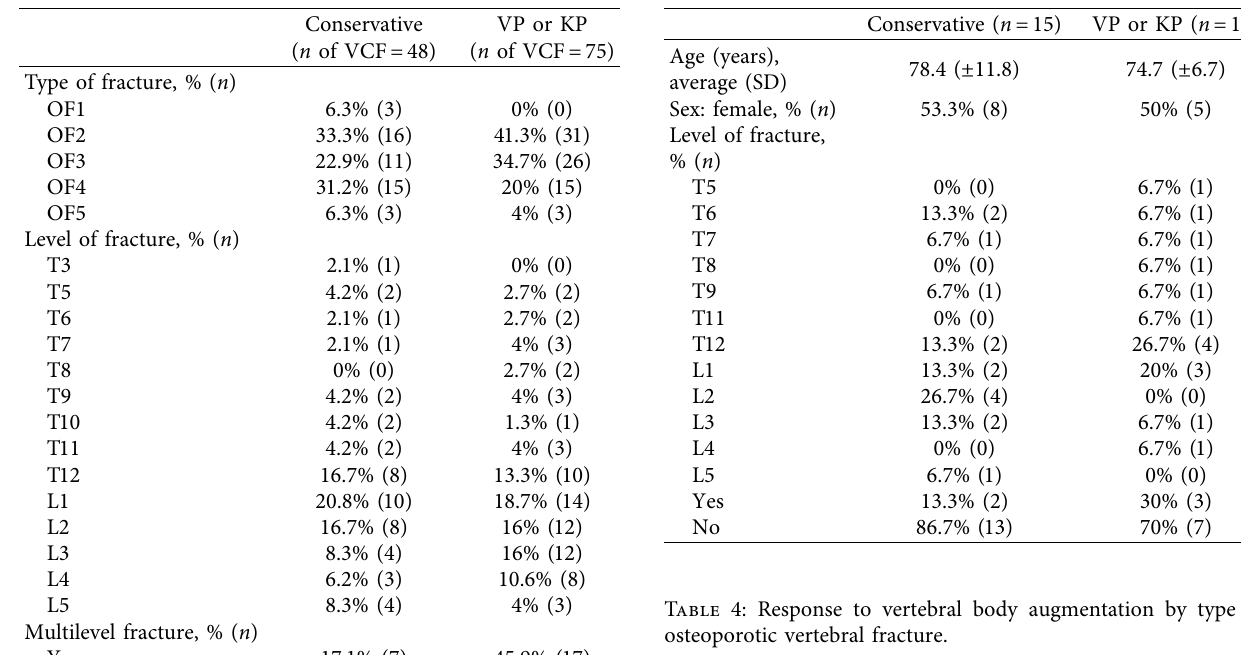
Table 3: Demographics and level of OF4 type fractures in con- servative and VBA groups.